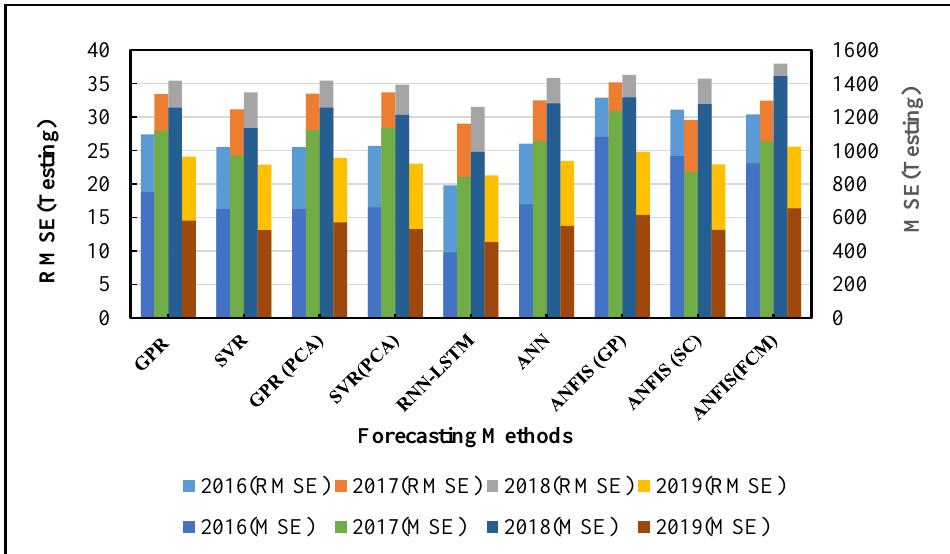
Figure 7. Comparison of RNN-LTSM test results of RMSE and MSE for p-si with other techniques over the period of four year (2016–2019).